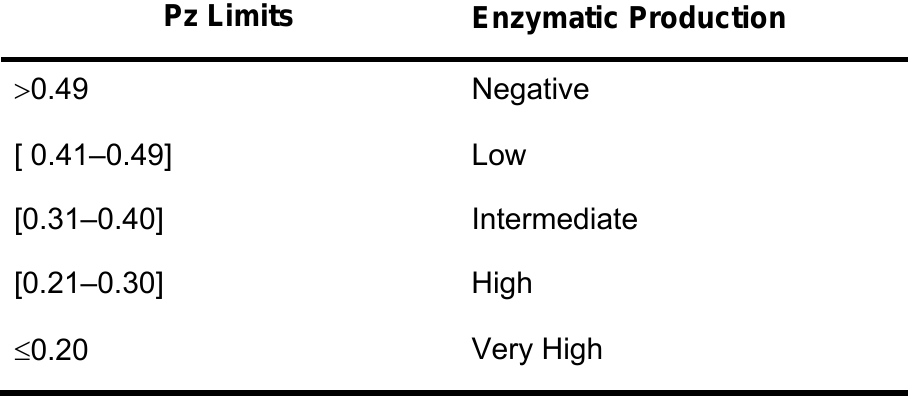
Table 1 . Characterization of proteolytic activity (Pz), as a function of the ratio between colony diameter (Dc) and colony diameter plus degradation zone diameter (Dc +